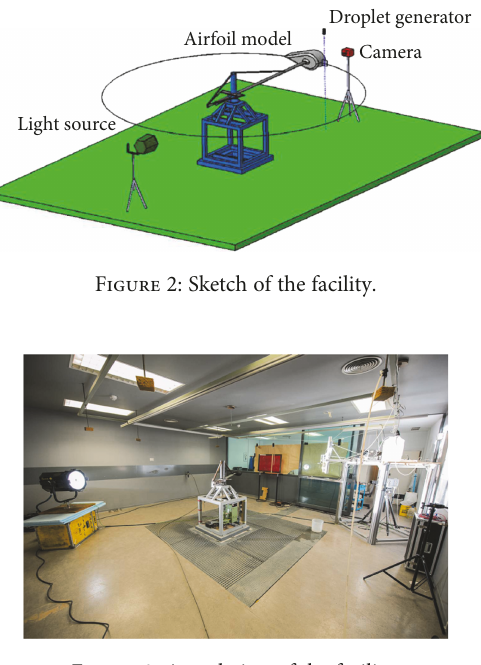
Figure 3: Actual view of the